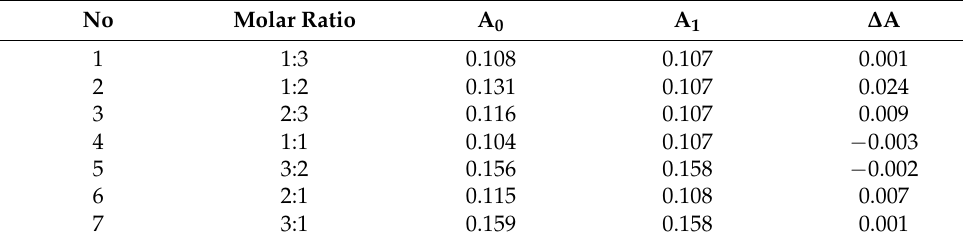
Table 1. Molar ratio experiments of RBG/ β -CD system.